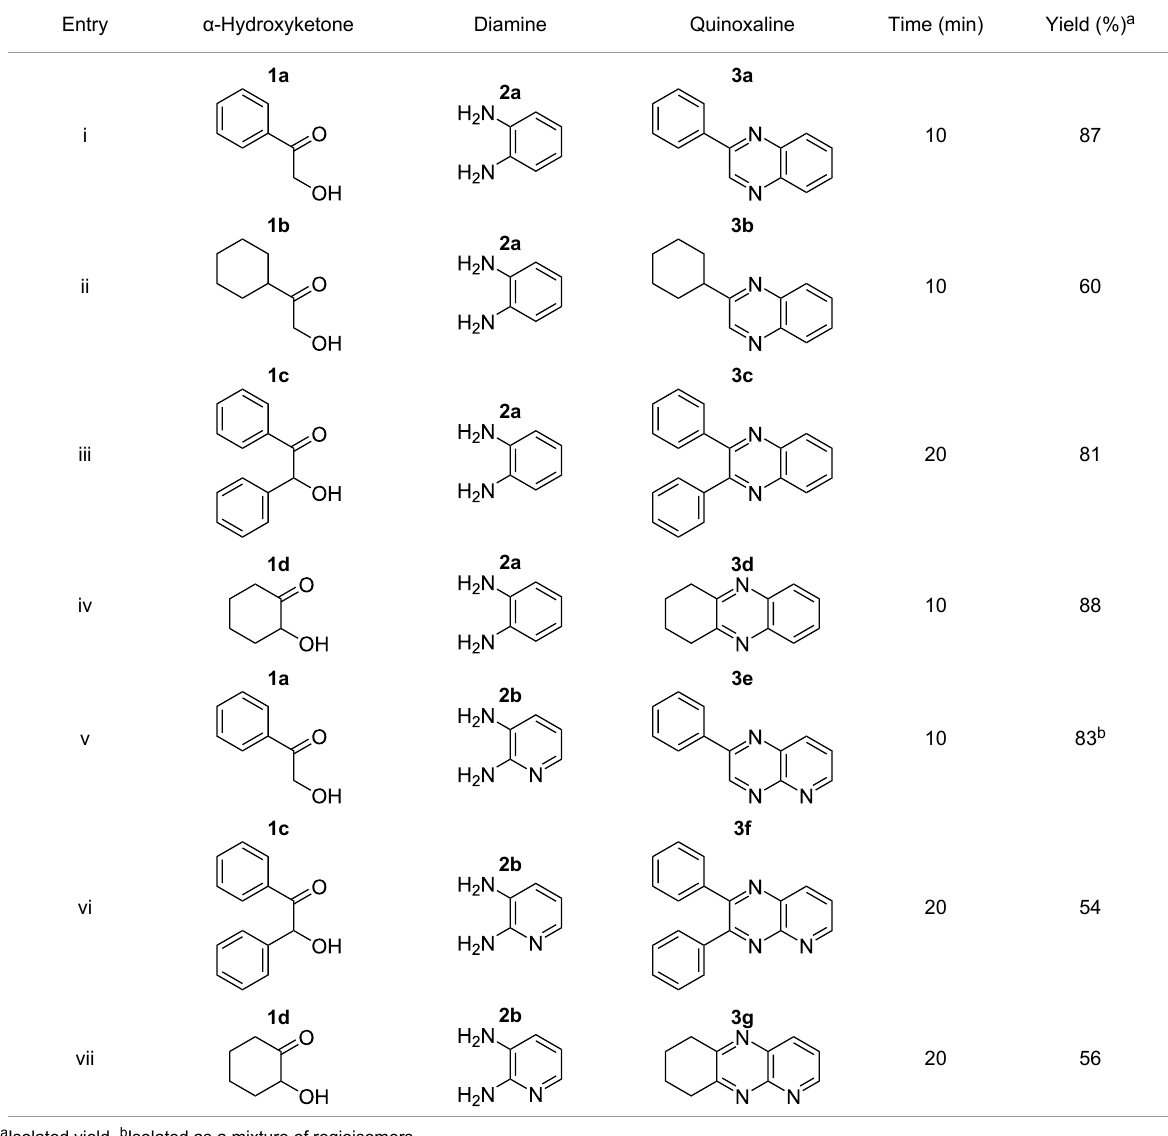
Table 2: Titanium dioxide catalysed tandem oxidation process under microwave irradiation.